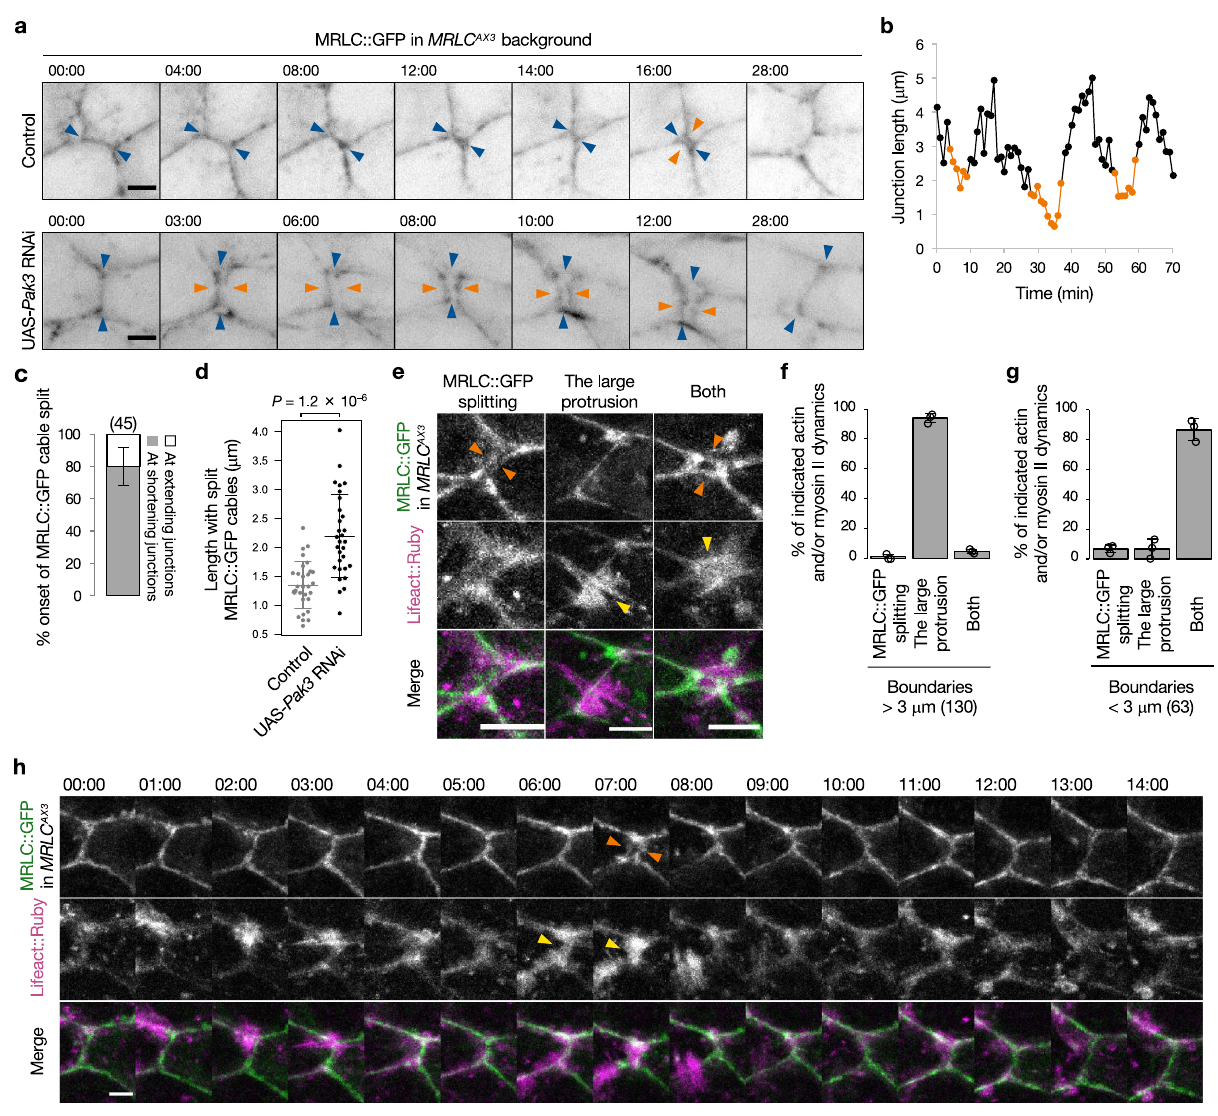
Fig. 3 Pak3 depletion causes the mislocalization of myosin II cables. a Representative time-lapse images of MRLC::GFP at the shortening junctions from >3 independent experiments. Orange and blue arrowheads indicate splitting myosin II cables and the positions of the edges of the junctions, respectively. Scale bar, 3 μ m. b Graph showing the length of a junction, and the timings at which the two distinct MRLC::GFP cables split along the junctions are shown in orange. c Mean± S.D. of timing of the onset of MRLC::GFP cable splitting along the junctions. Parentheses, the number of the MRLC::GFP cable splitting from 21 junctions of 3 pupae. d , Mean± S.D. of the lengths of junctions when the MRCL::GFP cables initiated splitting; n = 30 junctions from 3 (Control) and 4 (Pak3 RNAi) biologically independent pupae were examined. P -value by unpaired t -test. e Representative images of cell – cell junctions with split MRCL::GFP cables (orange arrowheads), the large actin protrusions (yellow arrowheads), and both in Pak3 RNAi cells (from the left). Scale bar, 5 μ m. f , g Mean± S.D. of the percentages of the dynamics categorized in ( e ) at cell – c e ll junctions larger than ( f ) and smaller than ( g ) 3 μ m. Parentheses, the number of examined junctions from n = 3 biologically independent pupae. h Representative time-lapse images of MRLC::GFP and Lifeact::Ruby at the cell – cell junction in Pak3 RNAi cells. Orange and yellow arrowheads indicate split MRLC::GFP cables and the large actin protrusions, respectively. Scale bar, 3 μ m. Genotypes: a , d MRLC AX3 /Y;MRLC-MRLC::GFP;AbdB-Gal4, UAS-H2B::ECFP/ + (Control) and MRLC AX3 /Y;MRLC-MRLC::GFP;AbdB-Gal4,